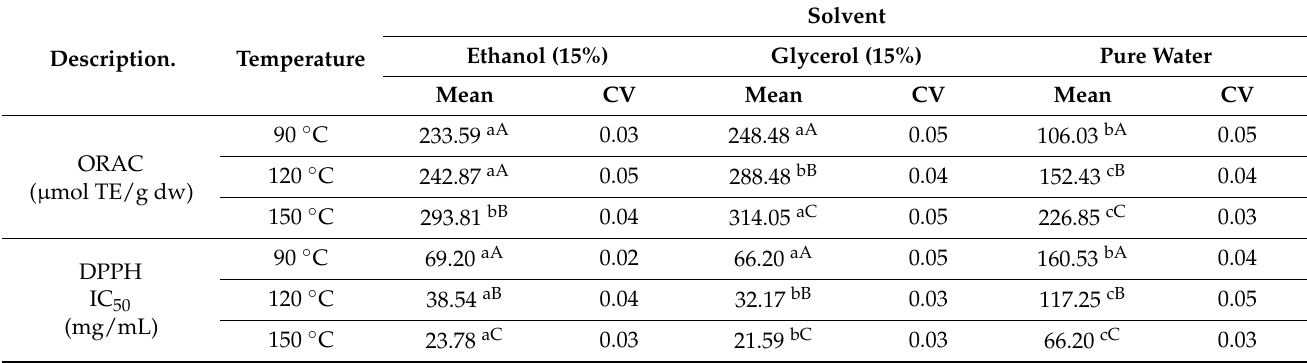
Table 2. Antioxidant capacity of the extracts obtained by HPLE.